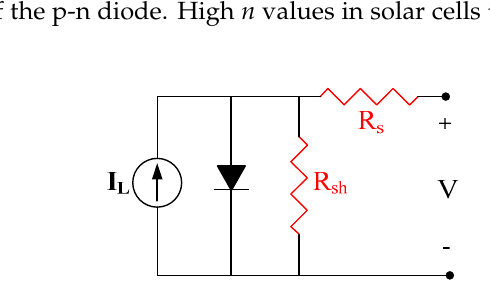
Figure 6. Equivalent circuit of solar cell with series resistance R s and shunt resistance R sh . Table 2. Summary of photovoltaic performance of samples A, B, C and D.